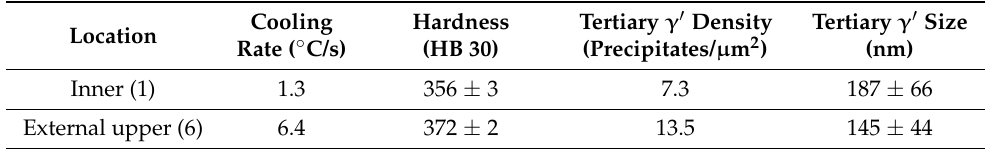
Table 5. Inner and external upper areas information, after